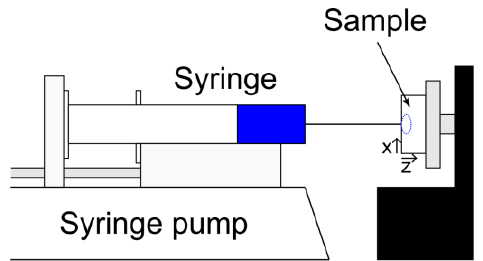
Figure 2. Setup of the apparatus for the dye solution permeation test. The sample is placed vertically, and the z-axis of the sample is defined as the direction of stacking nonwoven fabrics during CO 2 - assisted polymer compression preparation.